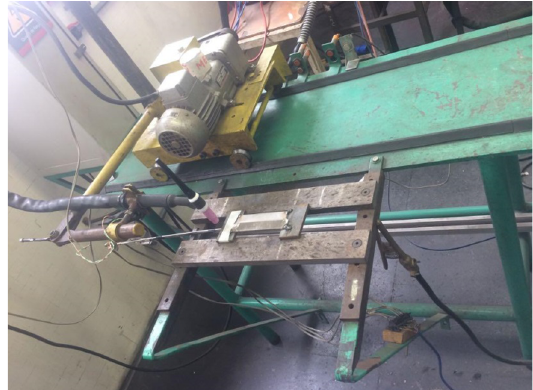
Figure 2. The positioning of the specimen and the contact